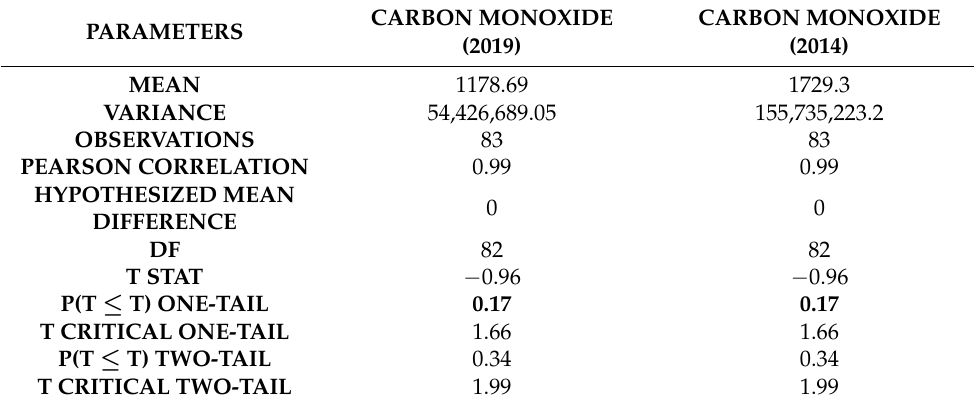
Table 3. Results of using two paired samples in the means T-test for H3 verification.